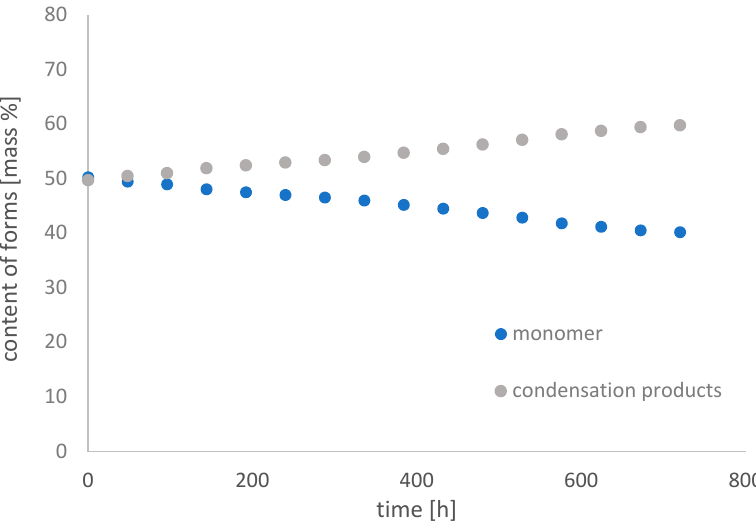
Figure 12. Change in the content of iron(III) ethylenediamine- N,N ′ -di[(2-hydroxy-5- sulfophenyl)acetic acid] forms with time in an aqueous solution at pH 5.